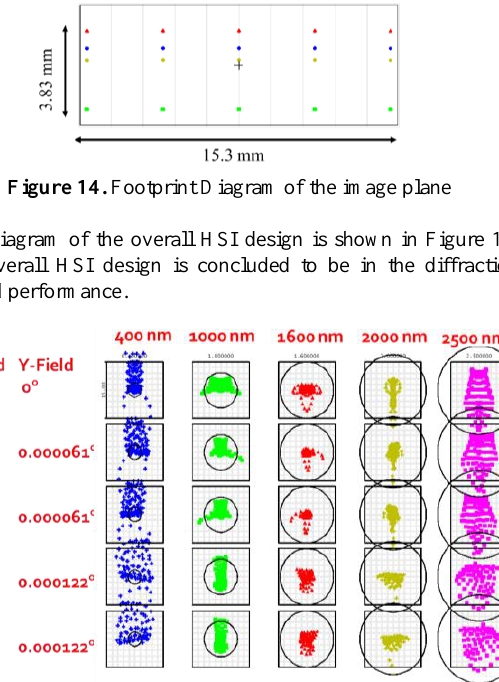
Figure 15. Spot diagram of the overall HSI design (Black circles represent Airy disk, black squares represent 15 μm square